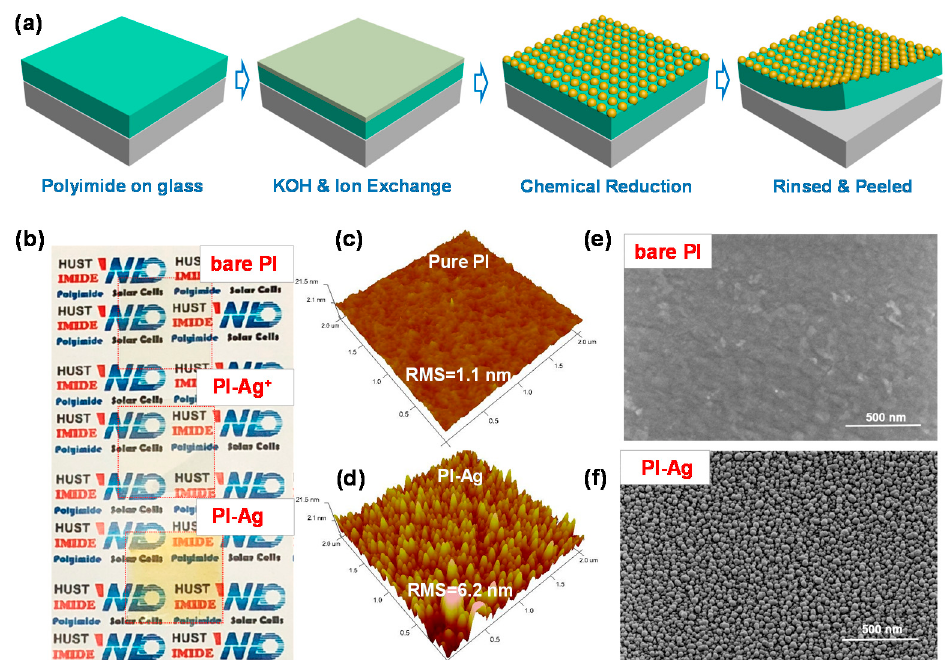
Figure 1. ( a ) The fabrication process of the surface-confined silver nanoparticle (Ag NP) polyimide (PI) substrate. ( b ) Photograph of the bare polyimide film, and films before and after dimethylamine borane (DMAB)-induced reduction of the ion-doped precursors. ( c , d ) The atomic force microscopy (AFM) image (2 × 2 µ m) of bare and DMAB-reduced PI. ( e , f ) Scanning electron microscopy (SEM) image of the bare and DMAB-reduced PI.